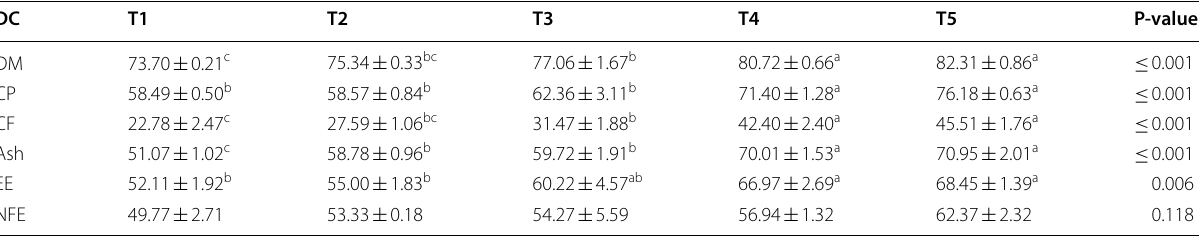
T1, basal diet with no additives; T2, basal diet supplemented with citric acid (10 g/kg) and no whey; T3, T2 T5, T2 whey powder (22.5 g/kg) + DM dry matter; CP crude protein; CF crude fiber; Ash ash; EE ether extract; NFE nitrogen free extract a–c Means within the same row carrying different superscripts are significantly different at (P